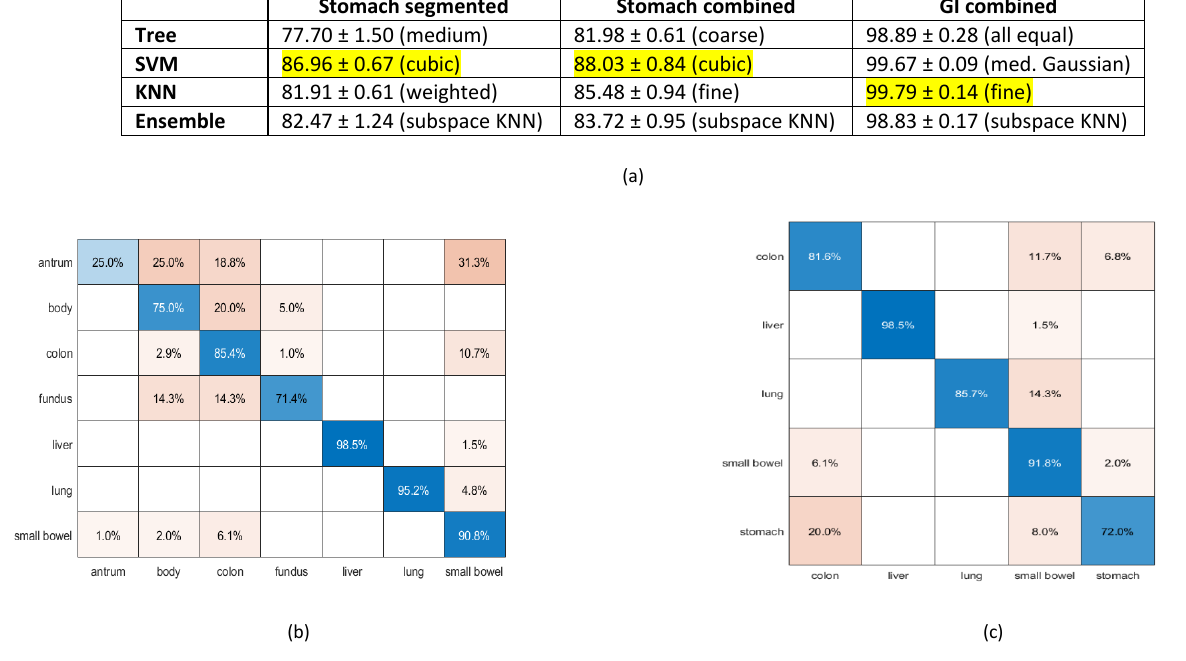
Fig. 6. (a) Comparison of mean accuracy with standard deviations for the different machine learning classification methods, along with best performing subclass. Confusion matrix plots generated from a single 10 fold cross-validation run using the cubic support vector machine subclass with (b) stomach separated out into fundus, body, and antrum and (c) fundus, body, and antrum aggregated together as stomach prior to comparison to other